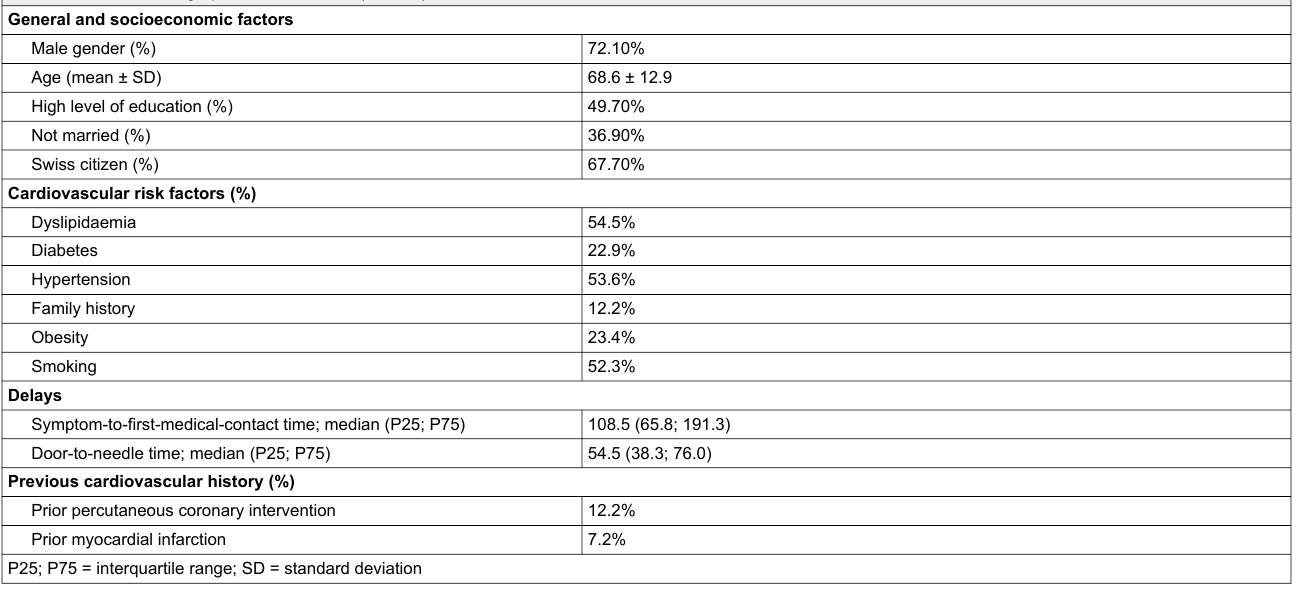
Table 1: Baseline demographic characteristics (n = 222). General and socioeconomic factors